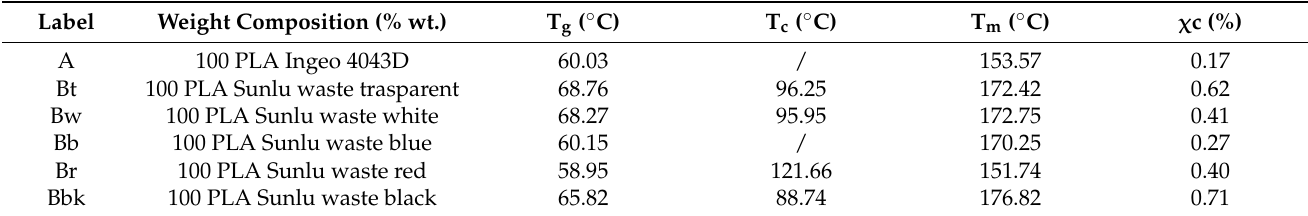
Table 2. Thermal properties of polymers and percentage of crystallinity χ c (%).